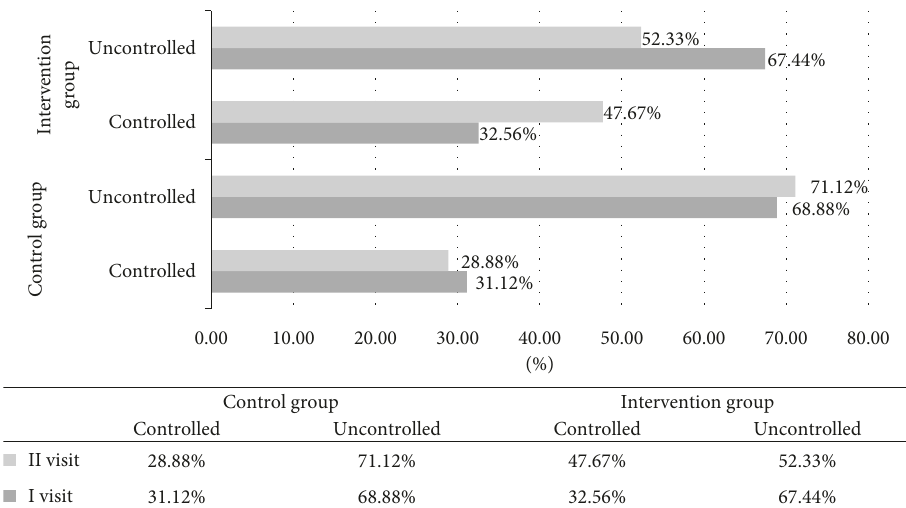
Figure 4: Comparison of asthma control between control and intervention